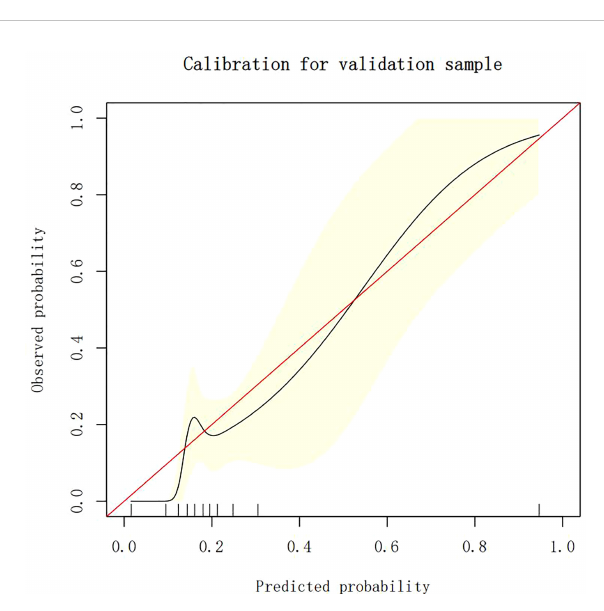
FIGURE 7 The calibration plots of the testing set by XG Boost ML. XG Boost ML, extreme gradient boosting (XG) machine learning (ML).